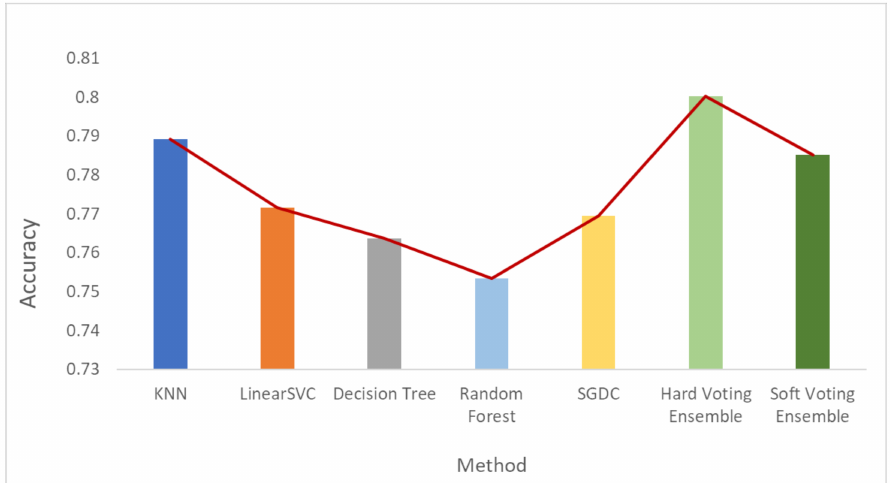
Figure 8. Accuracy results when the oversampled dataset was